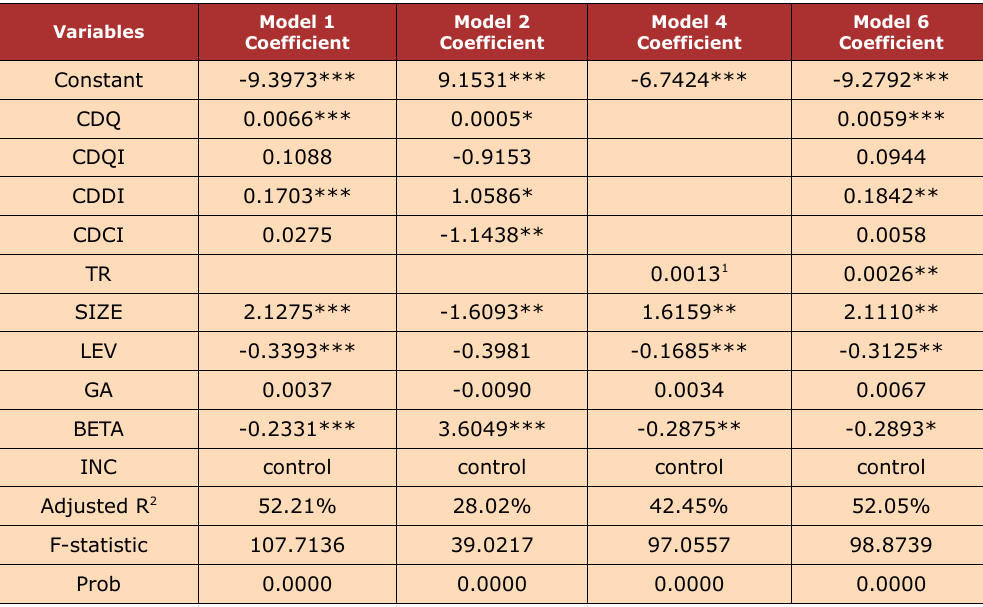
Table 4. Results of the mediating role of market liquidity